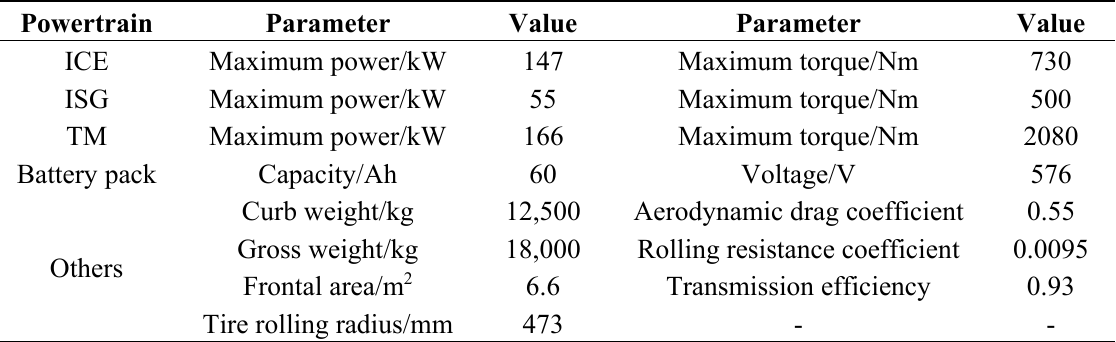
Figure 3. Powertrain configuration of the series-parallel PHEB. Table 1. The PHEB main